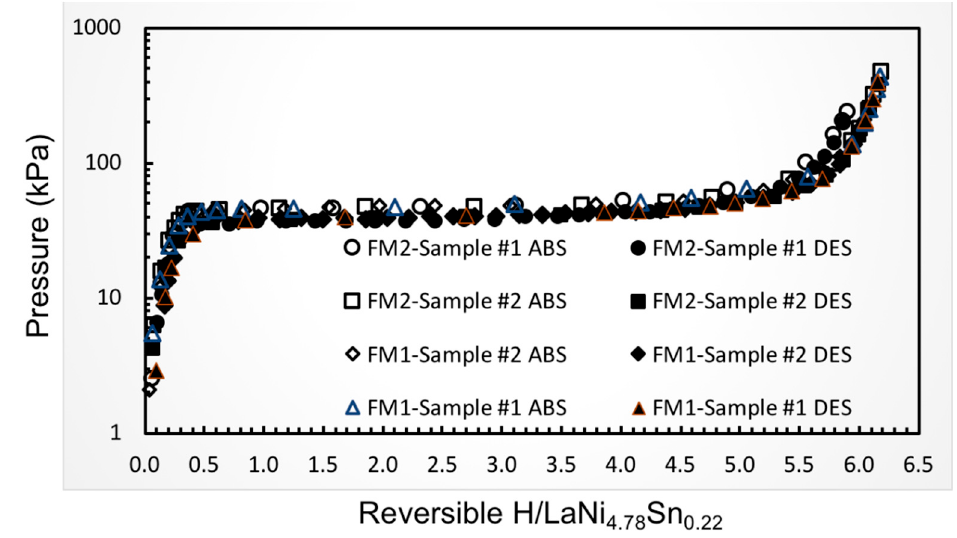
Figure 5. Hydrogen absorption and desorption isotherms at 300 K for two samples of the flight models FM1 and FM2 LaNi 4 . 78 Sn 0 . 22 alloys that are compiled for the first time from measurements initially performed at the University of Vermont by S. Luo, T. B. Flanagan, and R.C. Bowman, which had never been previously published.